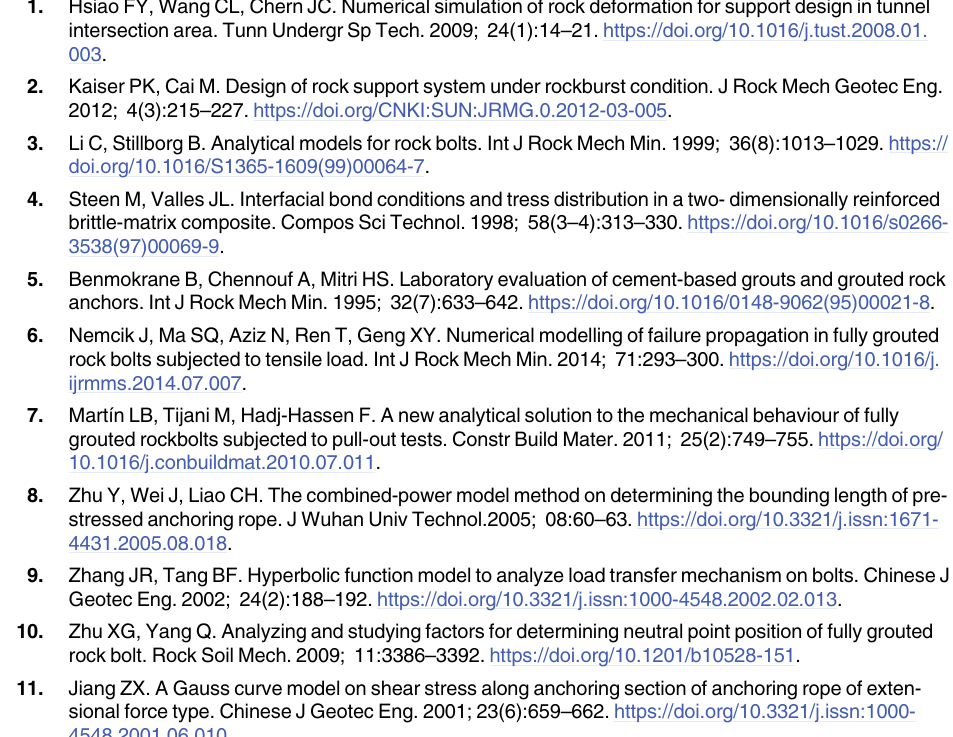
S1 Table. Parameters of mechanical properties of the test materials. S2 Table. Mechanical parameters of materials. S3 Table. A comparison between the peak axial force and β L